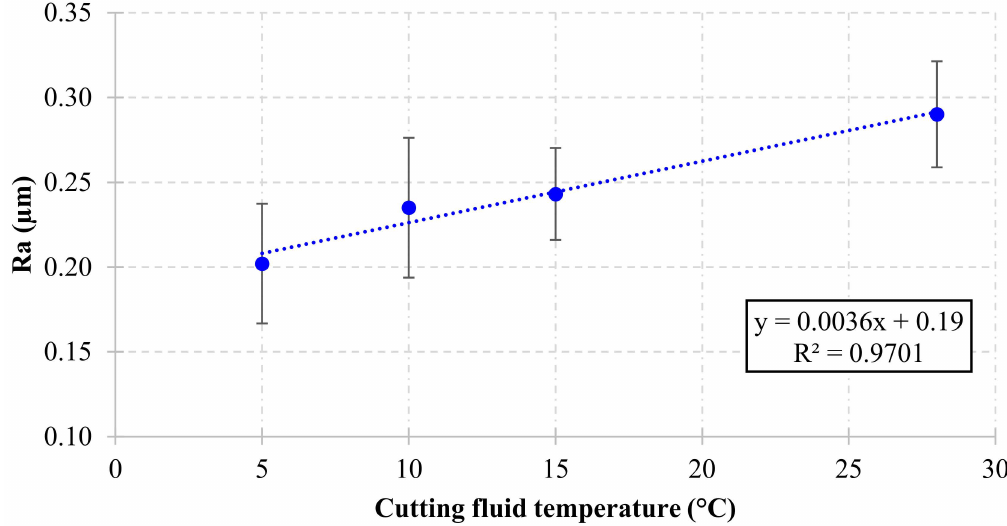
Figure 3. Surface roughness (Ra parameter) of the ground surface as a function of cutting fluid